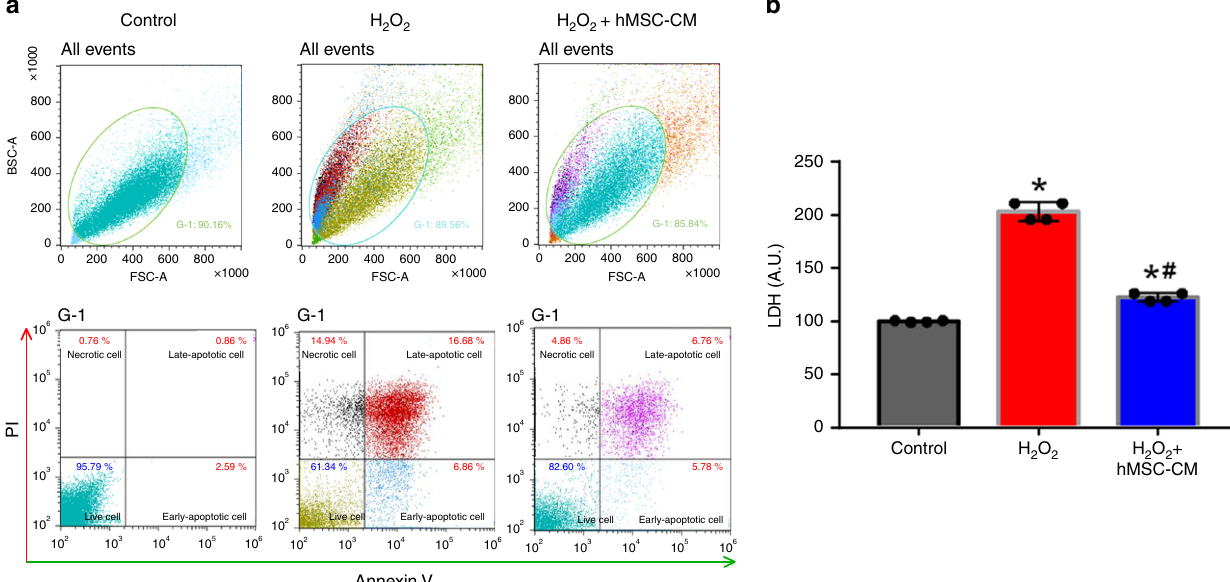
Fig. 6 Direct cytoprotective effects of the hMSC-conditioned medium on hiPSC-CMs undergoing simulated ischemic injury. a , b Treatment with hMSC- conditioned media (hMSC-CM) increased cell survival after H 2 O 2 (200 µ M) treatment as determined by the ( a ) Annexin V and ( b ) lactate dehydrogenase (LDH) assay. The data are represented as mean ± SEM. * p < 0.05 compared with untreated control group, # p < 0.05 compared with H 2 O 2 -only treated control group; n = 3 biologically independent samples per group. One-way ANOVA was used for statistical analyses hMSC-PA to signi fi cantly amplify cardiac repair. Synergistic regeneration through prolonged secretion of bene fi cial paracrine effects of intramyocardially injected hiPSC-CMs and epicardially factors as expected, but more importantly it improved the implanted hMSC-PA collectively rejuvenated the myocardium retention, distribution, engraftment, and maturation of hiPSC- and vessels post MI. Epicardially implanted hMSC-PA provided a CMs which ultimately augmented heart function and restored the complimentary microenvironment which enhanced vascular injured myocardium (Fig. 8). NATURE COMMUNICATIONS| (2019) 10:3123